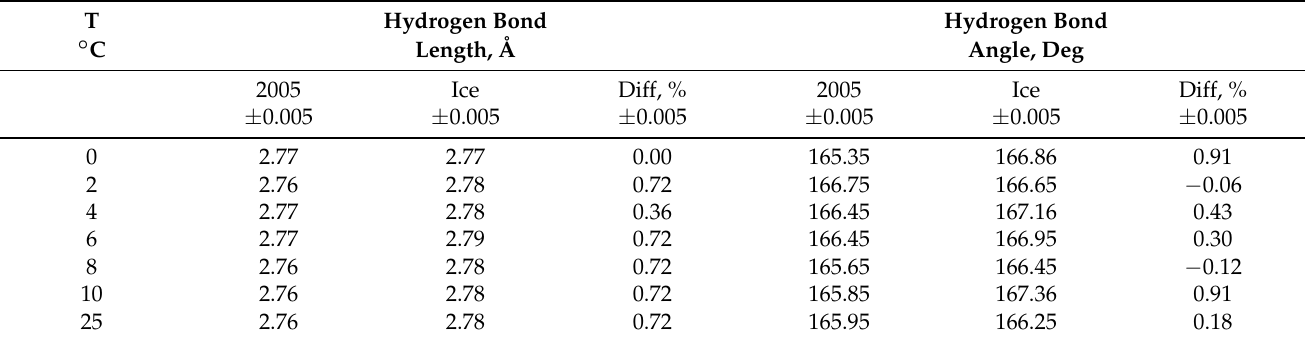
Table 4. Hydrogen bond lengths and angles at various temperatures and 0 MPag for pure water systems. Bond lengths and angles are based on a Gaussian kernel density estimation, and the values presented correspond to the highest density in each system. 2005: TIP4P/2005 [80]; Ice: